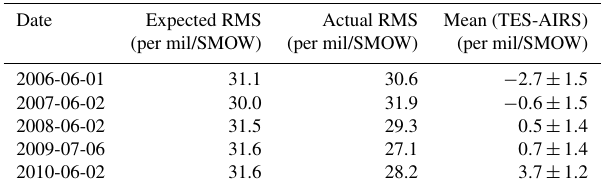
Table 1. Comparison between averaged TES and AIRS HDO / H 2 O ratio (750–350hPa). The units are in parts per thousand relative to Standard Mean Ocean Water. The second column shows the ex- pected RMS based on the uncertainties of the TES and AIRS data. The third column shows the actual RMS difference between TES and AIRS. The last column shows the mean